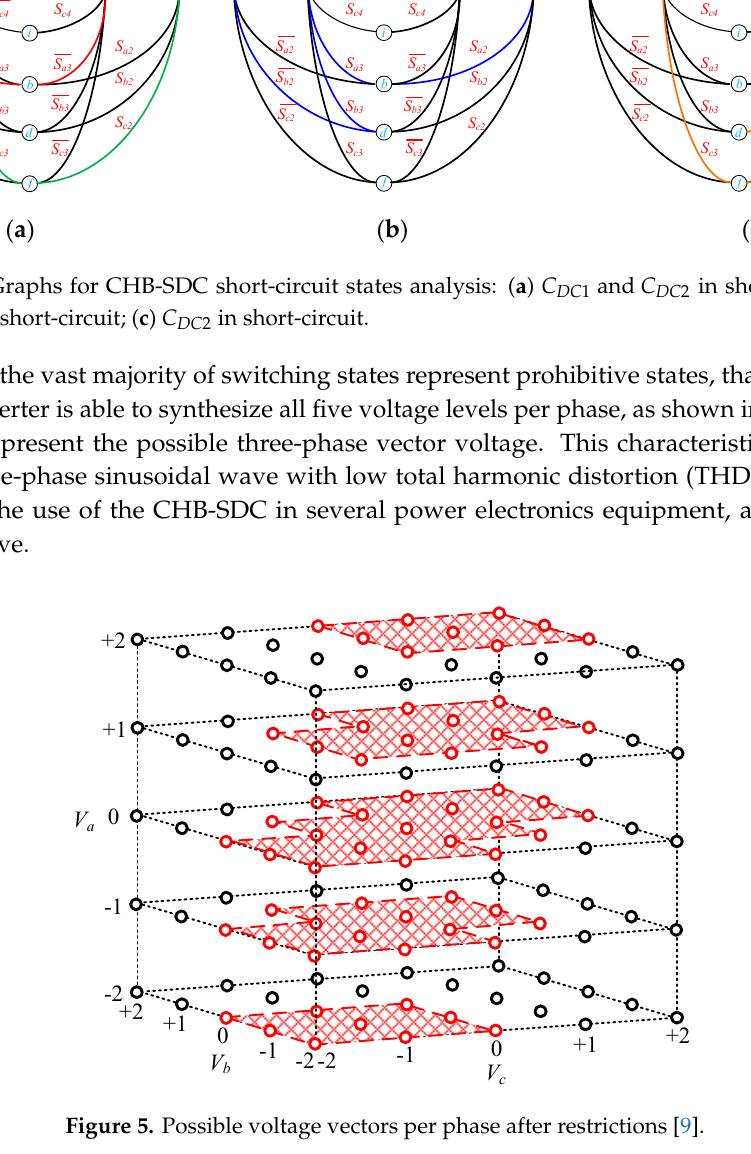
Figure 4. Graphs for CHB-SDC short-circuit states analysis: ( a ) 𝐶 (cid:3005)(cid:3004)(cid:2869) and 𝐶 (cid:3005)(cid:3004)(cid:2870) in short-circuit [9]; ( b ) 𝐶 (cid:3005)(cid:3004)(cid:2869) in short-circuit; ( c ) 𝐶 (cid:3005)(cid:3004)(cid:2870) in short-circuit.